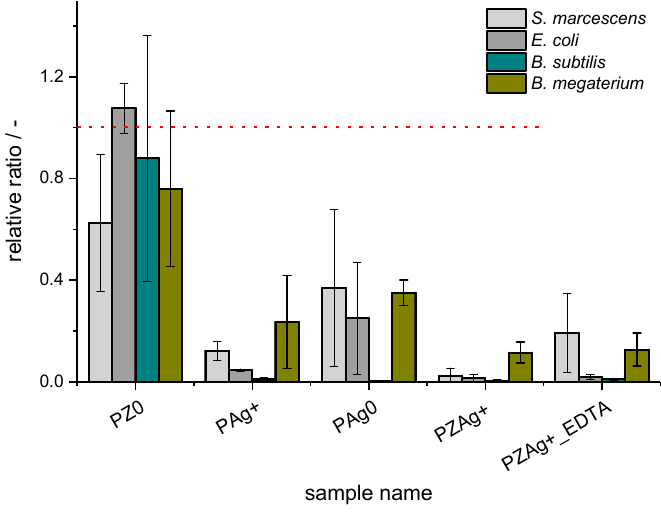
Figure 1. The relative ratio of adenosine phosphates as compared to control values (bacteria).